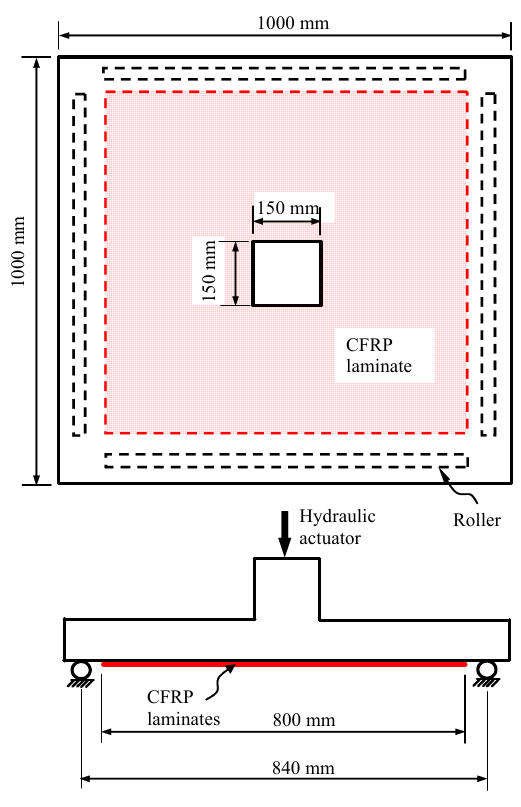
Figure 4. Test setup.